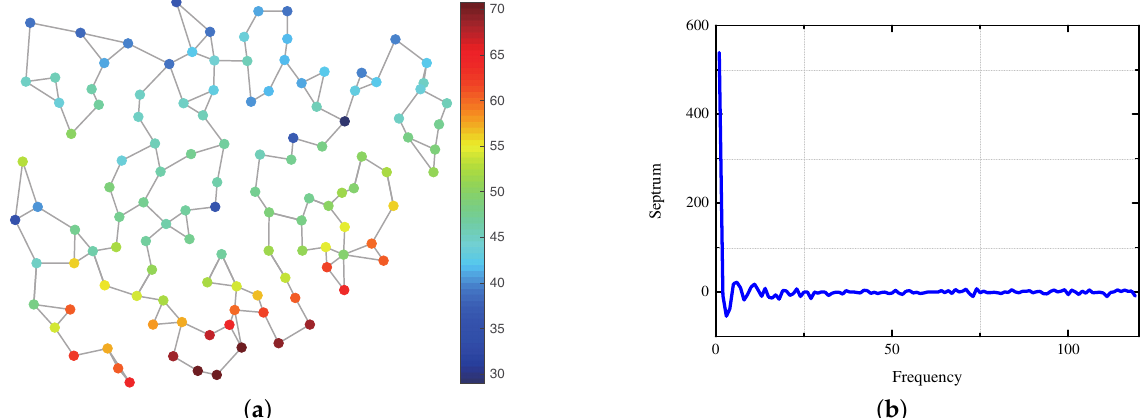
Figure 6. GS constructed from the temperature measured by 119 stations on 1st January 1998 and its spectrum. ( a ) GS on the 3-NN graph. ( b ) Spectrum of the GS in ( a